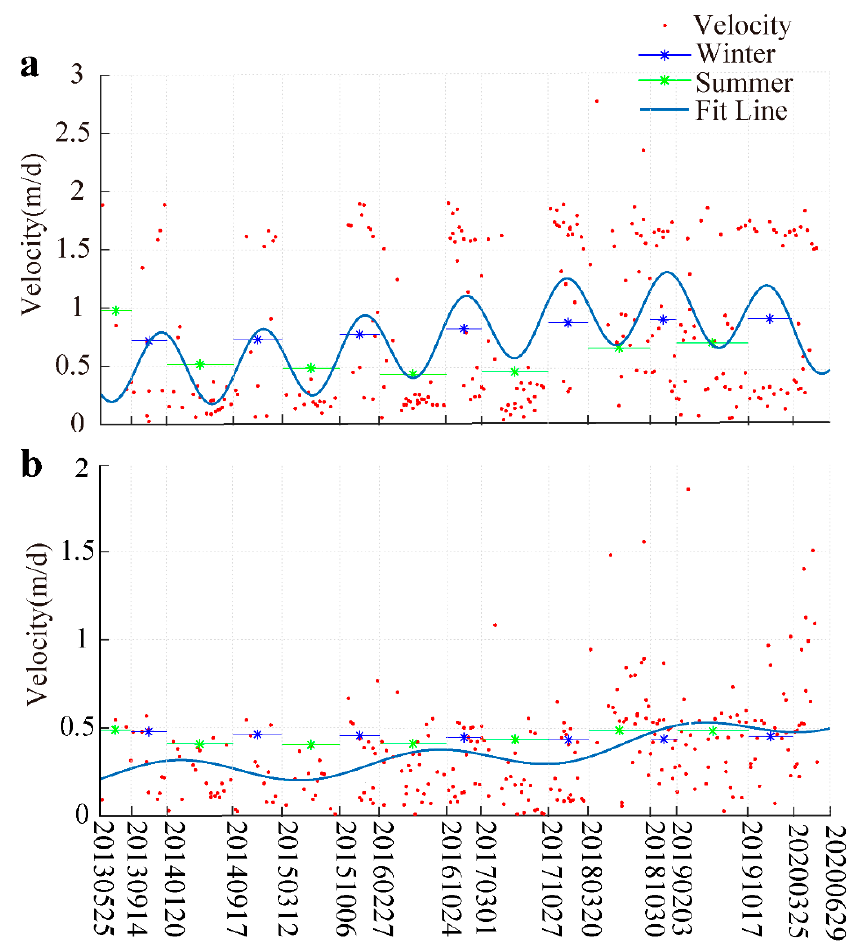
Figure 10. Surface velocity in the Yanong Glacier at two locations: ( a ) near the ELA line (Figure 4, S1); ( b ) near the terminus (Figure 4 S2); data points are velocity retrievals from image pairs acquired in a short time interval; mean summer (green) and winter velocities indicated by dots with horizontal segments indicating the temporal window applied to estimate the mean seasonal velocities (see Figure 2). The blue line has been obtained by fitting a three-terms Fourier series to the observations.